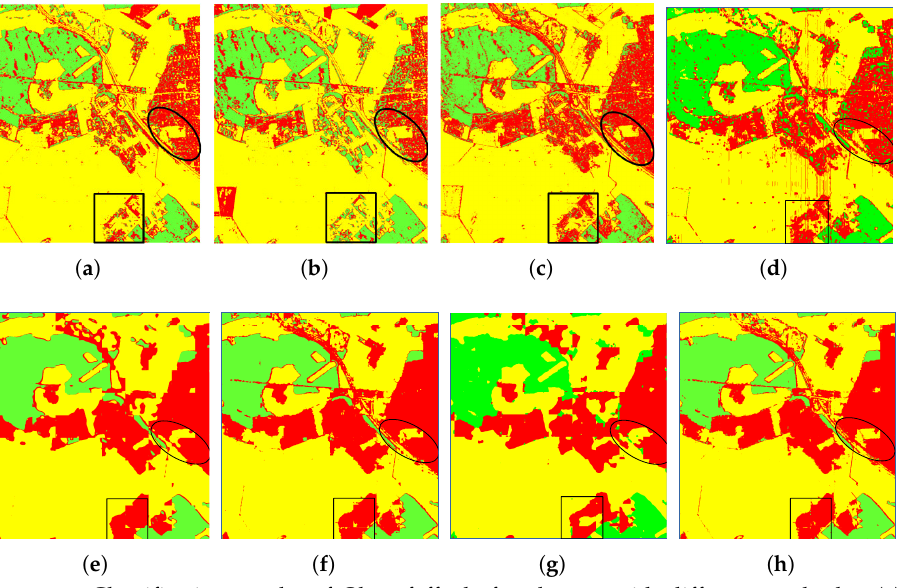
Figure 9. Classification results of Oberpfaffenhofen dataset with different methods. ( a ) SVM. ( b ) Wishart. ( c ) Bagging. ( d ) CNN. ( e ) SFCN. ( f ) CVFCN. ( g ) Unet. ( h )